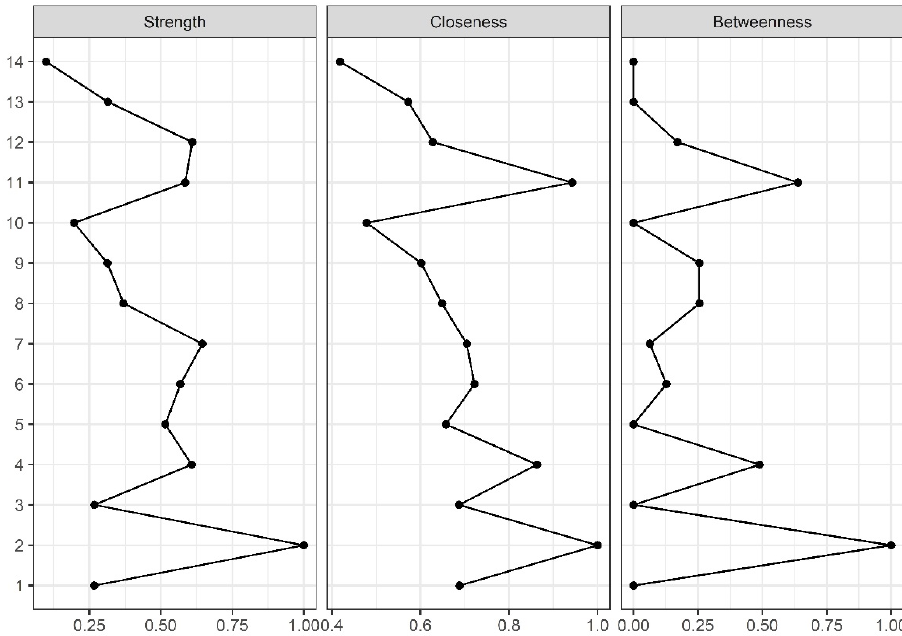
Figure 2. Centrality measures of Strength, Closeness, and Betweenness of each of the 14 nodes in the network. Centrality value of 1 indicates maximal importance, and 0 indicates no importance. The number of the variables are related to the network in Figure 1.